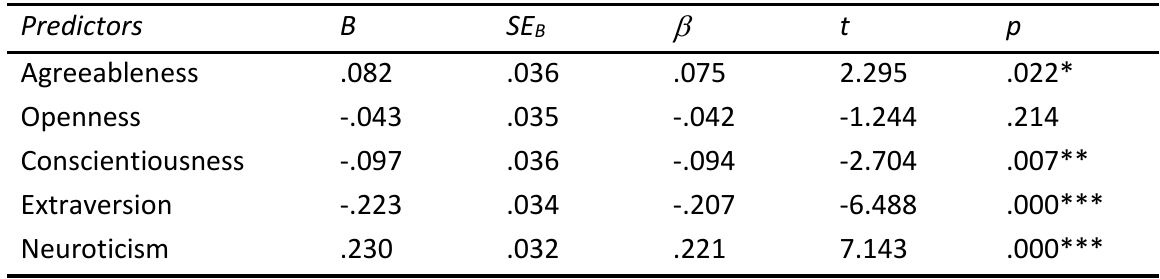
Table 5. Summary of Multiple Linear Regression Analysis with Personality Traits as Predictors of FLSA for ELL students